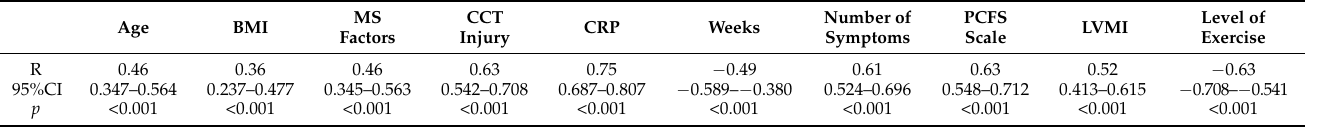
Table 3. Correlations between average E/e’ ratio and several clinical and laboratory data for the study